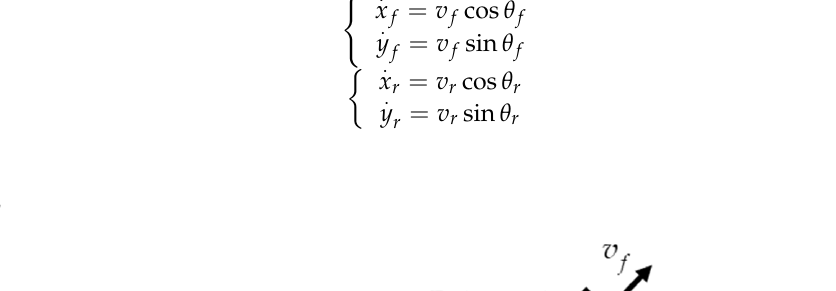
speed conditions, the changes of P f ( x f , y f ) and P r ( x r , y r ) are represented by the geometric relationships given in Figure 3.